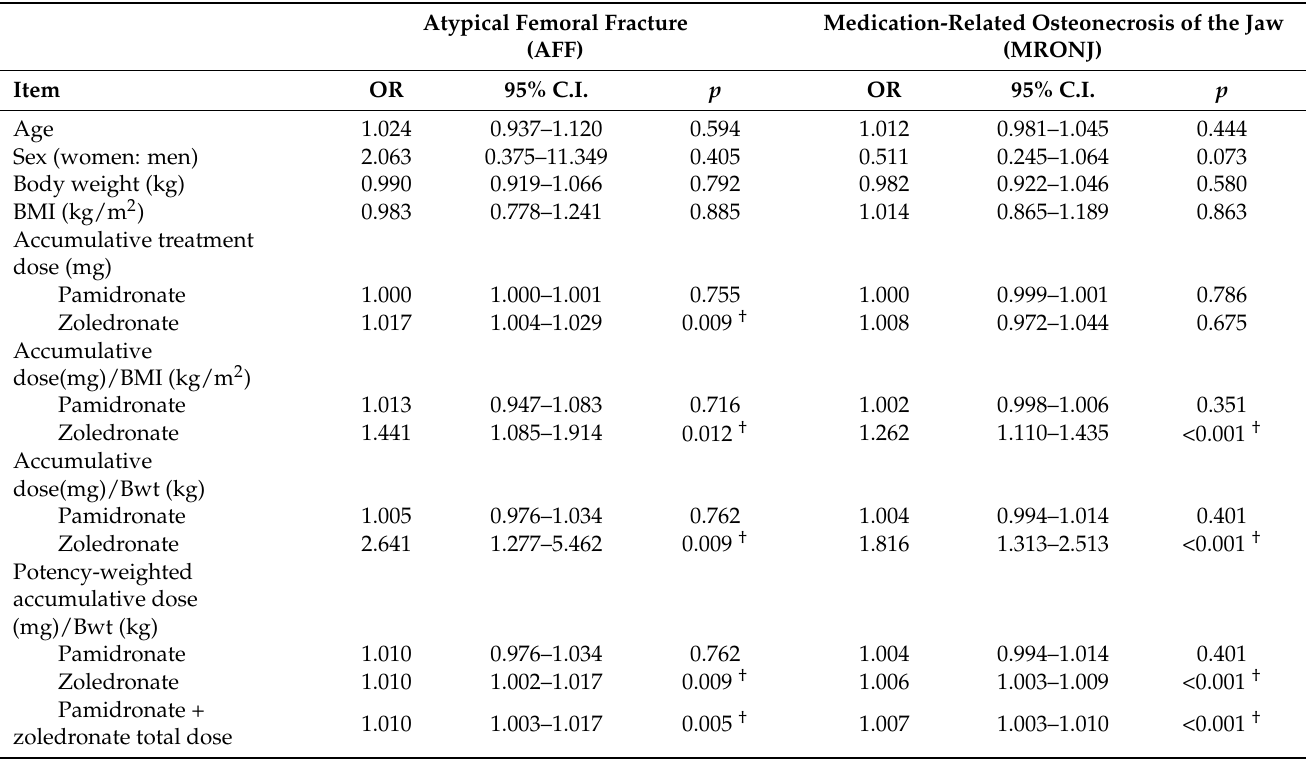
Table 2. Univariate and multivariate logistic regression analyses for risk factors of skeletal complications. Atypical Femoral